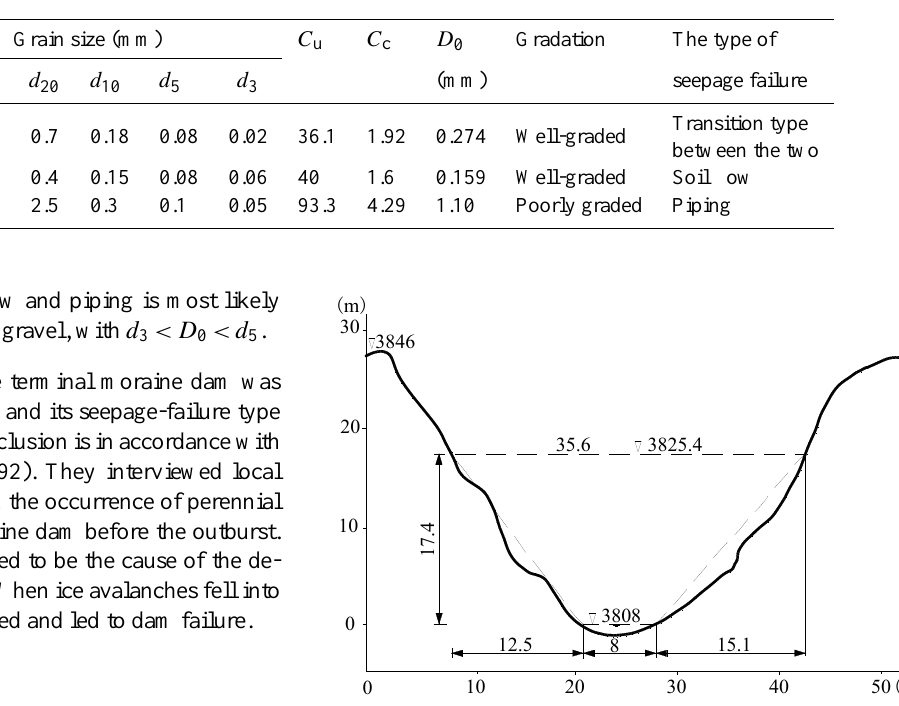
meters and the symbol ▽ represents altitude) 3